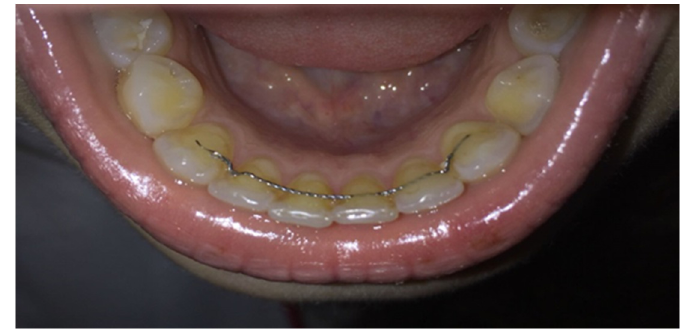
Figure 3. Inferior fixed retainer used in the study.